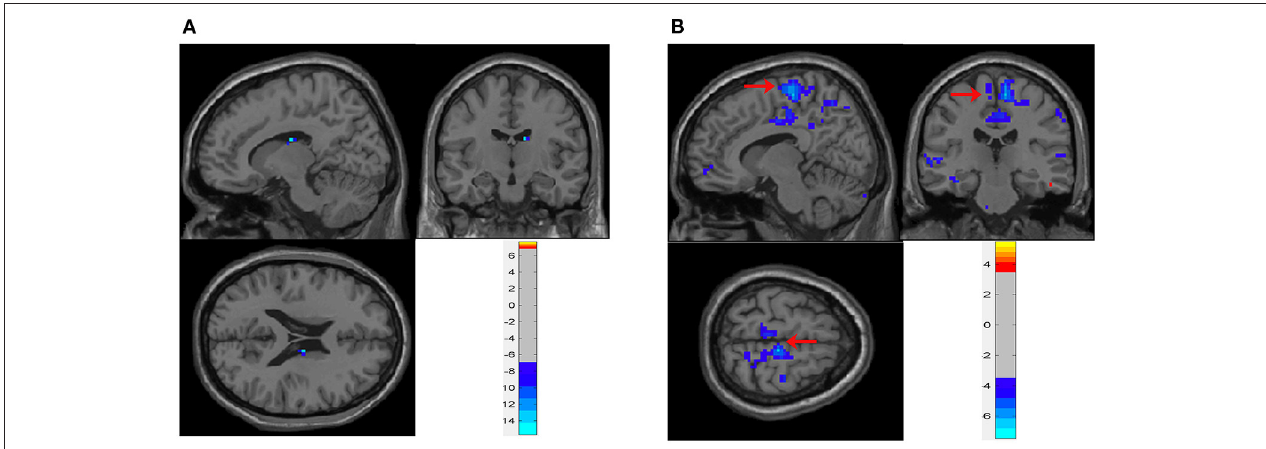
FIGURE 3 | Brain activity during neobladder continence. (A) Main effect analysis of neobladder continence in all subjects. There was a significant activation decrease in the thalamus and caudate nucleus (12, − 12, and 21) (cluster-level P ≤ 0.05, GRF correction). (B) Single-subject analysis of neobladder continence in subject no. 10. SMA showed a significant decrease in activation (arrows, also shown in Table 3 ) (cluster-level P ≤ 0.05, GRF correction). The first-level contrasts were defined by subtraction logic between CONTRACTION and REST. GRF, Gaussian random field; SMA, supplementary motor area.